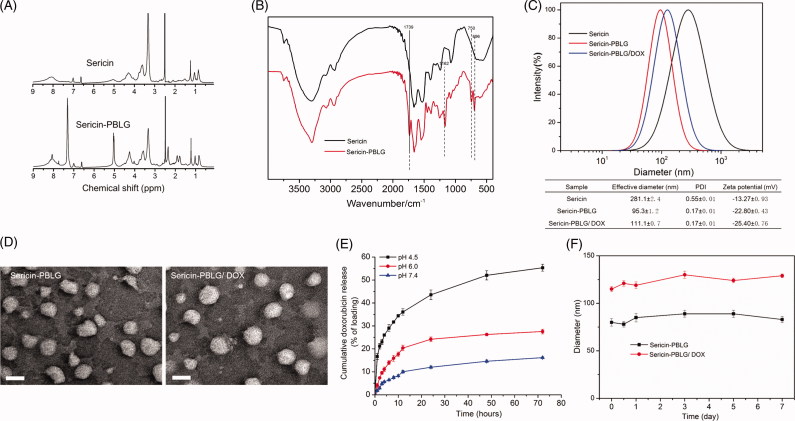
(A) 1H NMR spectra of sericin and sericin-PBLG. (B) FTIR spectra of sericin and sericin-PBLG. (C) The particle size and surface charge of sericin, sericin-PBLG, and sericin-PBLG-DOX micelles. (D) TEM images of sericin-PBLG and sericin-PBLG-DOX micelles. Scale bar, 50 nm. (E) pH-dependent release of DOX from sericin-PBLG-DOX micelles over 3 d (n = 3). (F) Stability of sericin-PBLG and sericin-PBLG-DOX micelles in PBS (pH 7.4, 0.1 M, 37 °C, n = 3).